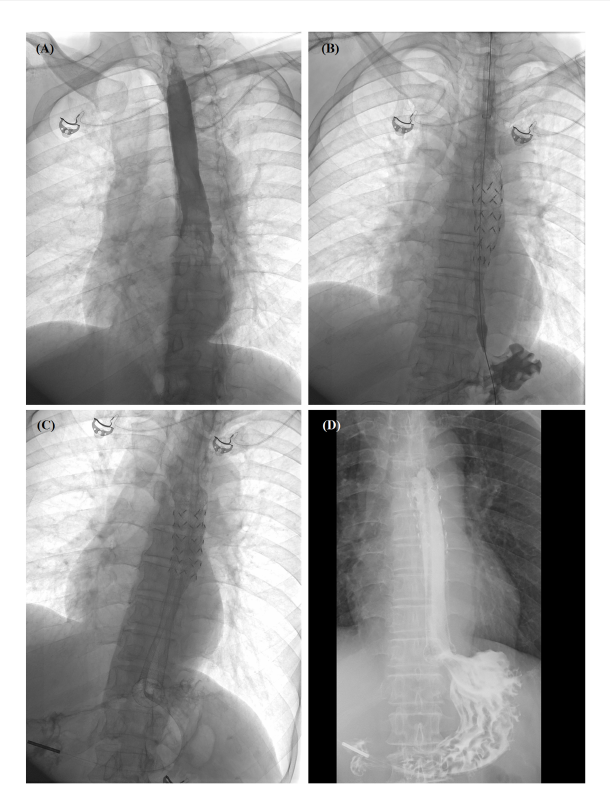
FIGURE 3 Self-expandable metallic stent (SEMS) insertion procedure. (A) Anteroposterior esophagography showed complete obstruction in the lower esophagus. (B) The delivery system of segmental radioactive metal stent was inserted, and stent migration happened. (C) Another fully covered SEMS was released by withdrawing the sheath. (D) Esophagography con fi rmed that the contrast agent passed smoothly after stent placement. SEMS, self-expandable metallic stent.